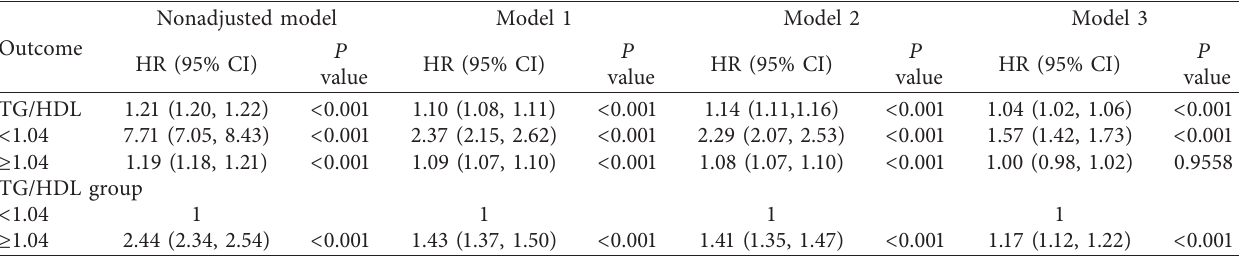
Table 5: The association between TG/HDL and impaired glucose tolerance in a multiple regression model. Outcome